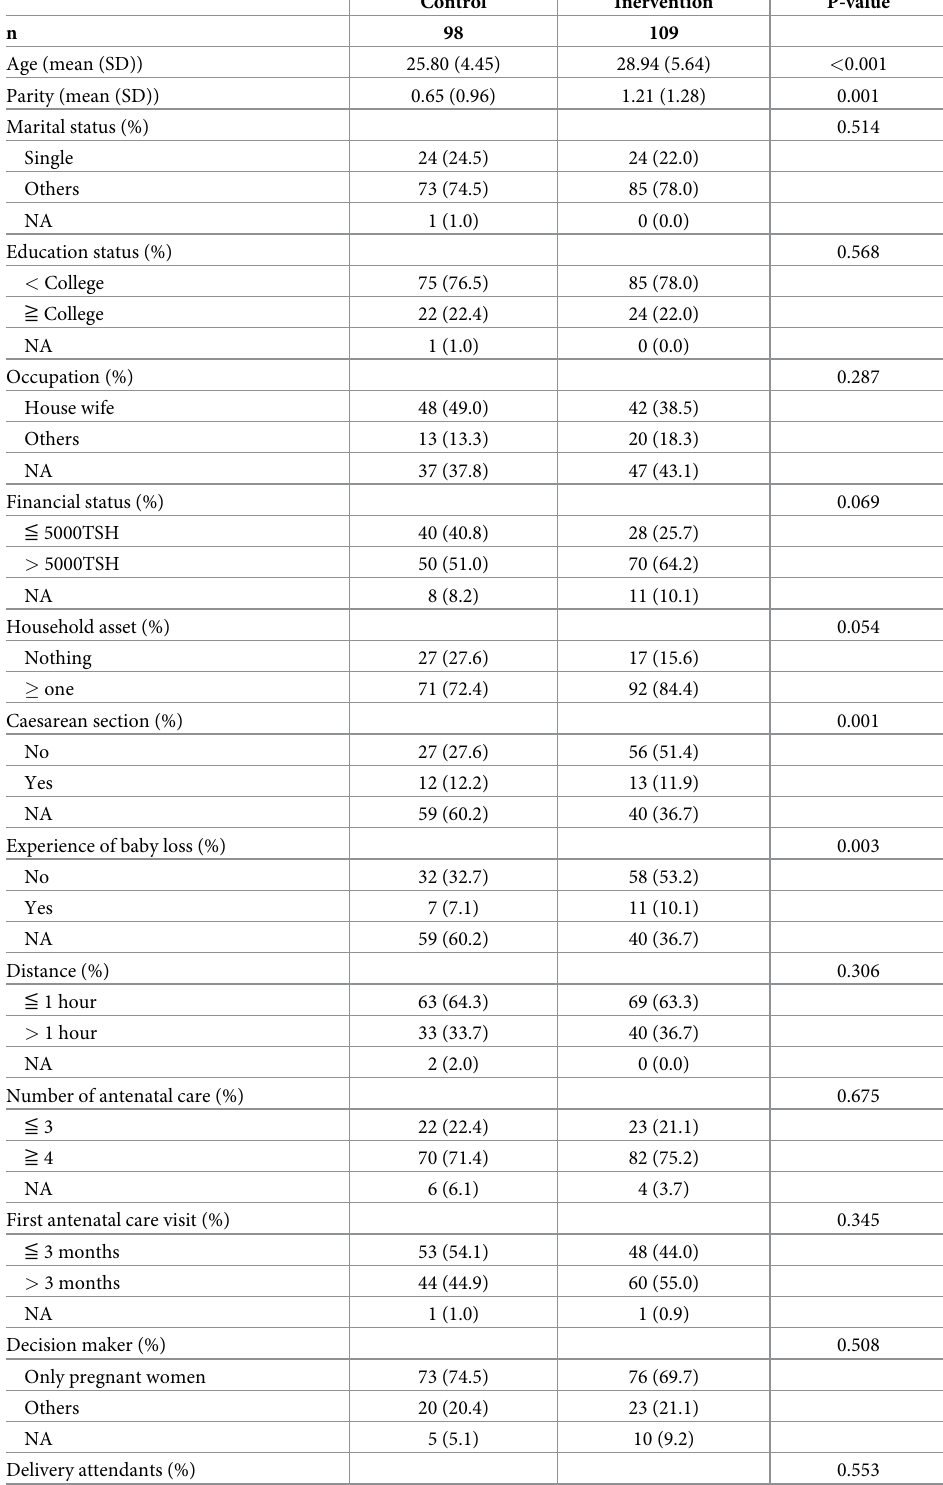
Table 3. Demographic characteristics of the pregnant